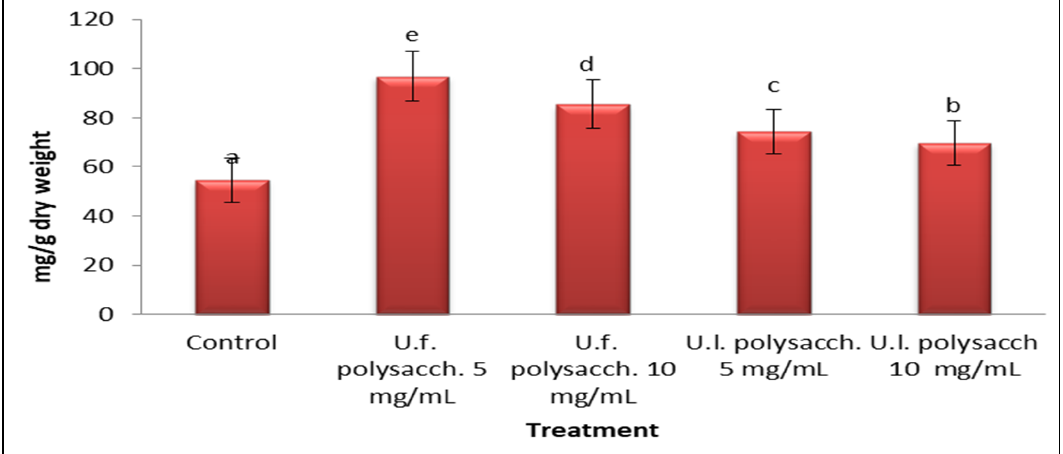
Figure 11. Effect of seed priming with different concentrations of soluble polysaccharides on the protein content of Zea mays growing seeds. The bars represent the standard error (the different letters denote the significant values among the treatments). U.f., Ulva fasciata; U.l., Ulva lactuca.